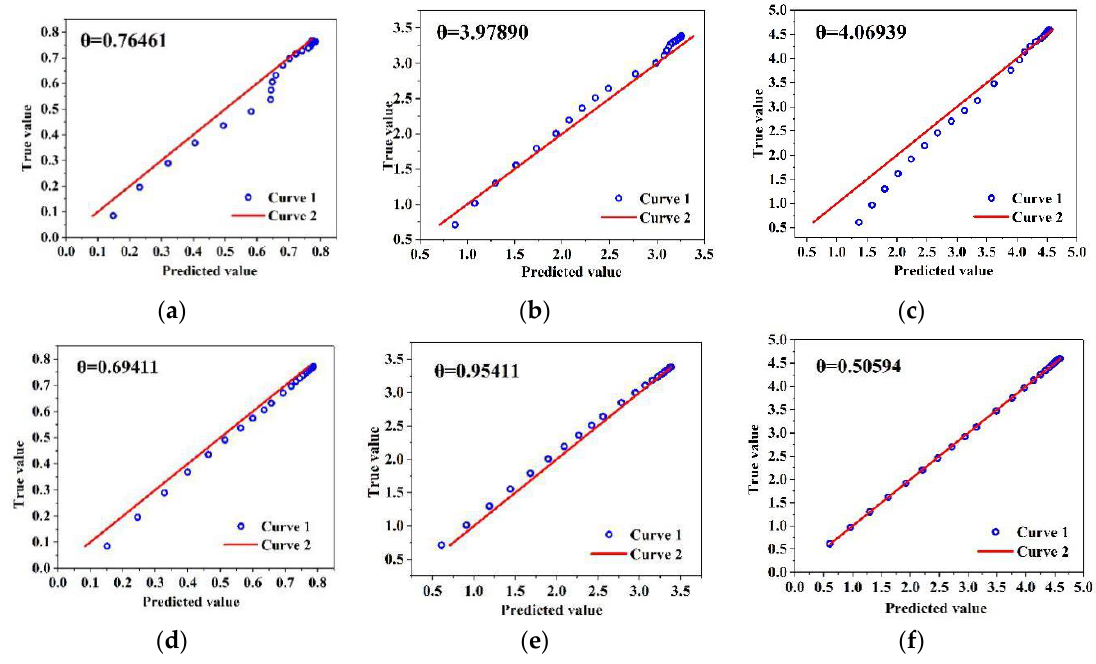
Figure 6. Analysis of the fitting degree for MLP and CNN models. ( a ) MLP model at G = 153.7 W/m 2 ; ( b ) MLP model at G = 653.4 W/m 2 ; ( c ) MLP model at G = 909.0 W/m 2 ; ( d ) CNN model at G = 153.7 W/m 2 ; ( e ) CNN model at G = 653.4 W/m 2 ; ( f ) CNN model at G = 909.0 W/m 2 .